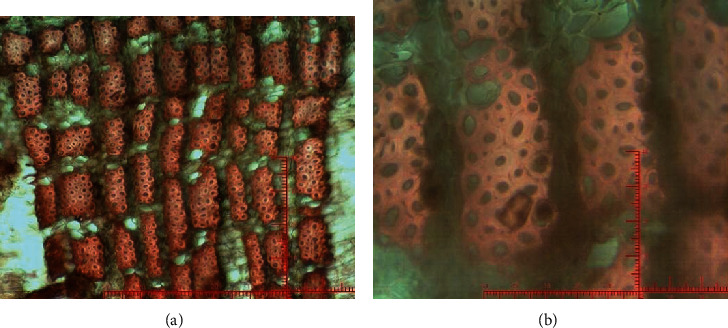
(a, b) Zoomed in view of schlerenchymatous fiber cells (phloem fiber) of tossa jute plant.